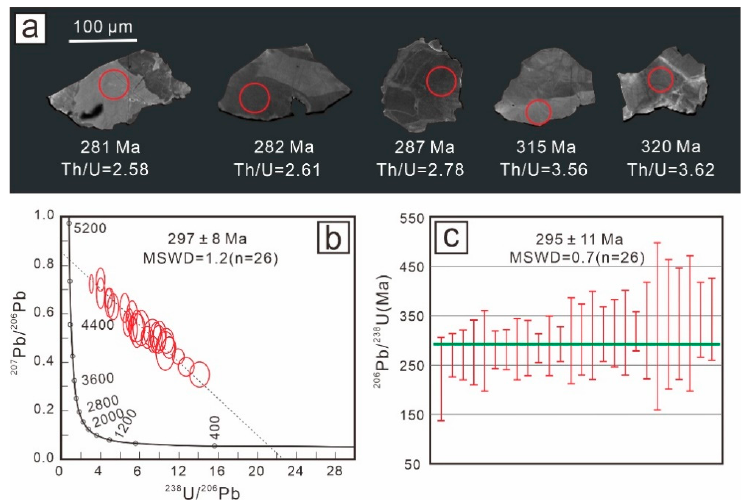
Figure 5. CL image of apatite grains from monzogranite sample 21HK01 ( a ). Apatite Tera-Wasserburg concordia plots for Muniushan apatite U–Pb analyses ( b ). Weighted mean 206 Pb/ 238 U ages for Muniushan apatite U-Pb analyses ( c ).